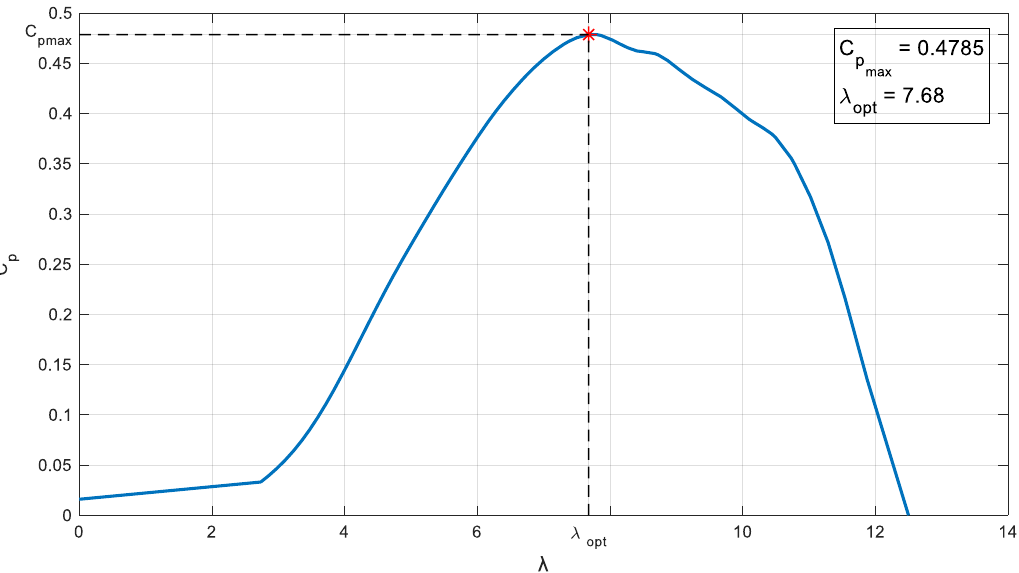
Figure 10. Final 𝜆 - 𝐶 𝑝 curve obtained from three Bornay Wind Plus 25.3+ small wind generators.